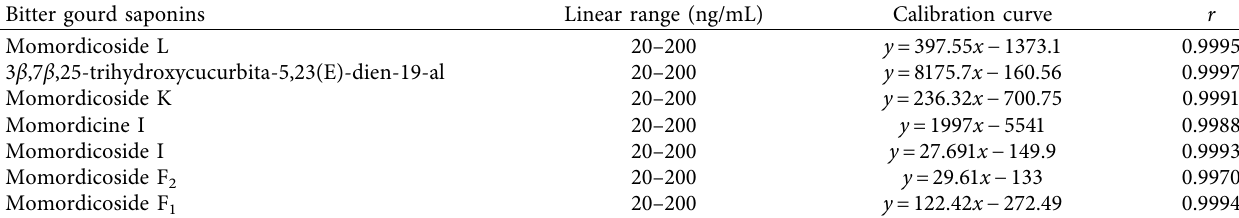
Table 2: Calibration curve for specific bitter gourd saponins by UPLC-ESI/MS/MS.